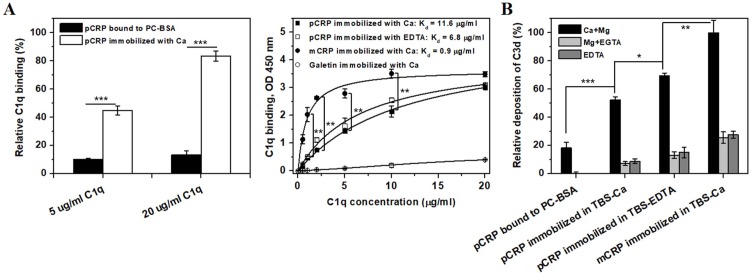
The surface-induced intermediate exhibited enhanced complement interaction capacity.5 μg/ml pCRP or mCRP was immobilized in TBS-Ca or TBS-EDTA (pH 7.4) at 4°C overnight. Alternatively, 50 μg/ml pCRP was bound to immobilized PC-BSA overnight at 4°C in TBS-Ca (pH 7.4). The amount of pCRP bound to PC-BSA or immobilized onto surfaces was evaluated by a poly-clonal anti-CRP antibody and corrected when required. (A) C1q at the indicated concentrations was added to immobilized or bound proteins for 1 h followed by detection with C1q antibody. Directly immobilized pCRP exhibited three to five-fold stronger capacity than captured pCRP to bind C1q (***p < 0.001), and immobilized mCRP exhibited the highest C1q binding affinity of all (**p < 0.01: immobilized pCRP vs immobilized mCRP). (B) Wells were incubated with 5% normal human serum (NHS) diluted with VBS, 1% gelatin containing 0.15 mM Ca+0.5 mM Mg, 5 mM EGTA+0.5 mM Mg, or 5 mM EDTA, for 1 h at room temperature. The serums have been adsorbed with PC-BSA to eliminate trace level of CRP and anti-PC antibodies. The activation of complement was evaluated by C3d deposition. The bound and immobilized proteins all interacted with C1q and activated solely the classical complement pathway with the capacities in an increasing order of pCRP bound to immobilized PC-BSA, pCRP immobilized in TBS-Ca, pCRP immobilized in TBS-EDTA, immobilized mCRP. *p < 0.05; **p < 0.01; ***p < 0.001. All data were obtained from at least three independent experiments and represented as mean ± SEM. For A right, values underwent a nonlinear curve fit with OriginPro 8 software, during which the category was set as “Growth/Sigmoidal” and the function was set as “Hill1”.